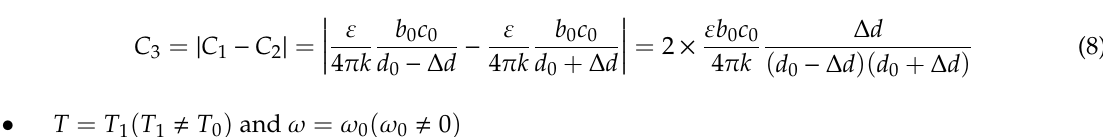
Figure 4. Combs of moving plates and fixed plates when and